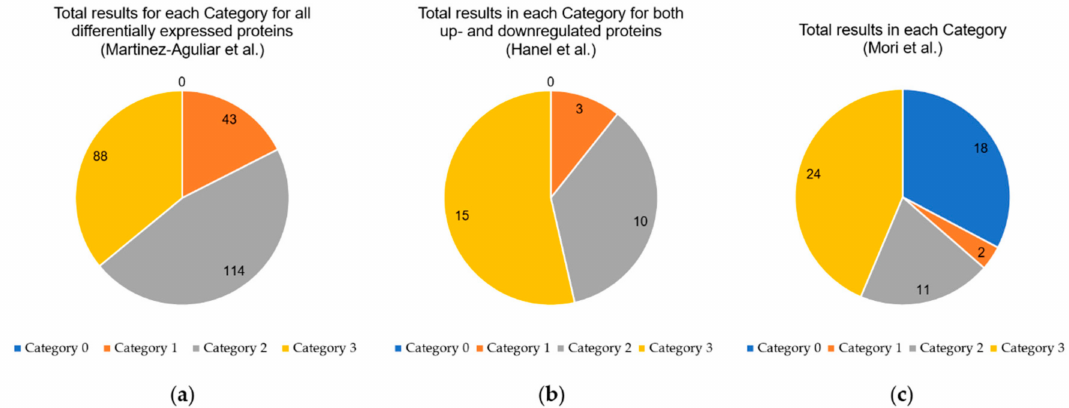
Figure 1. Distribution of the di ff erent categories for all proteins analysed by the OmixLitMiner tool. ( a ) The results of Martinez-Aguilar et al. [9]; ( b ) the results of Hanel et al. [10]; ( c ) the results of Mori et al. [11]. Category 1: review articles found; Category 2: original papers found, but no reviews; Category 3: no articles found; Category 0: protein absent in reviewed UniProt database (see Section 4.2 for